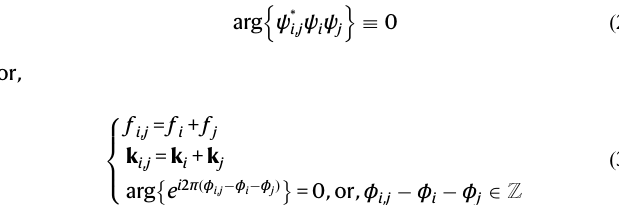
the symbol # index the most substantial peaks in descending order of their amplitudes, as speci fi ed in Table 1. The solid black isolines denote amplitudes at 6 ms − 1 and the vertical dashed line indicates the central day of the 2019 new year stratospheric sudden warming event. Readers with colour vision de fi - ciencies are referred to Supplementary Fig. 1 for color- fi ltered versions of the current fi gure.